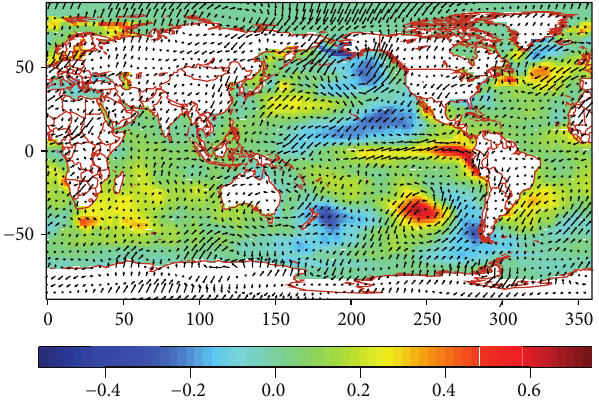
Figure 10: Difference between positive and negative composites of MAM EOF1 with SSTs and 850 mb